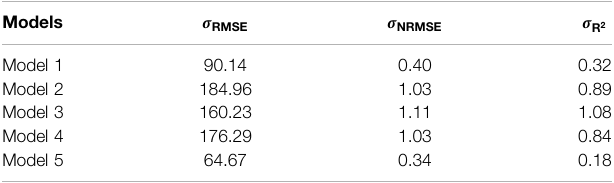
TABLE6| Standarddeviationsofevaluationindicesofpredictionmodelsbetween prediction